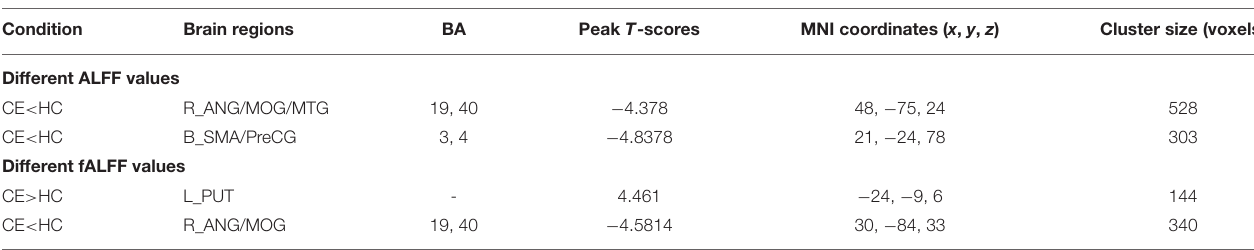
TABLE 2 | Different ALFF values between the two groups. Condition Brain